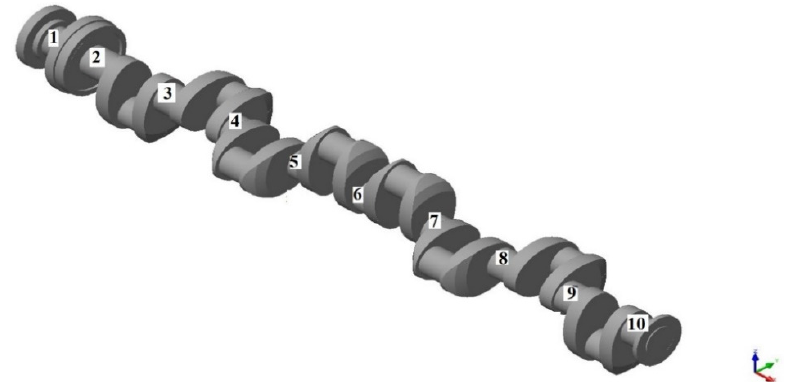
Figure 9. Modelled medium-speed marine main drive crankshaft with numbered main journals.